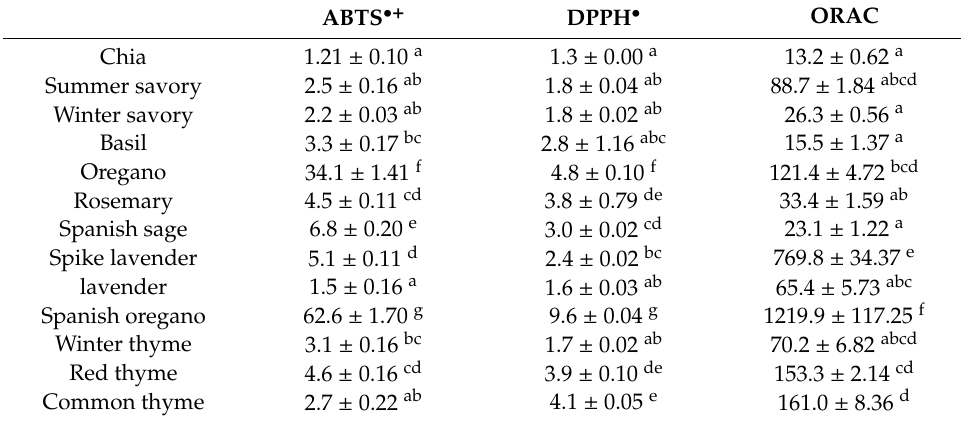
Table 5. Seed oil antioxidant activities ( µ mol Trolox / g oil).